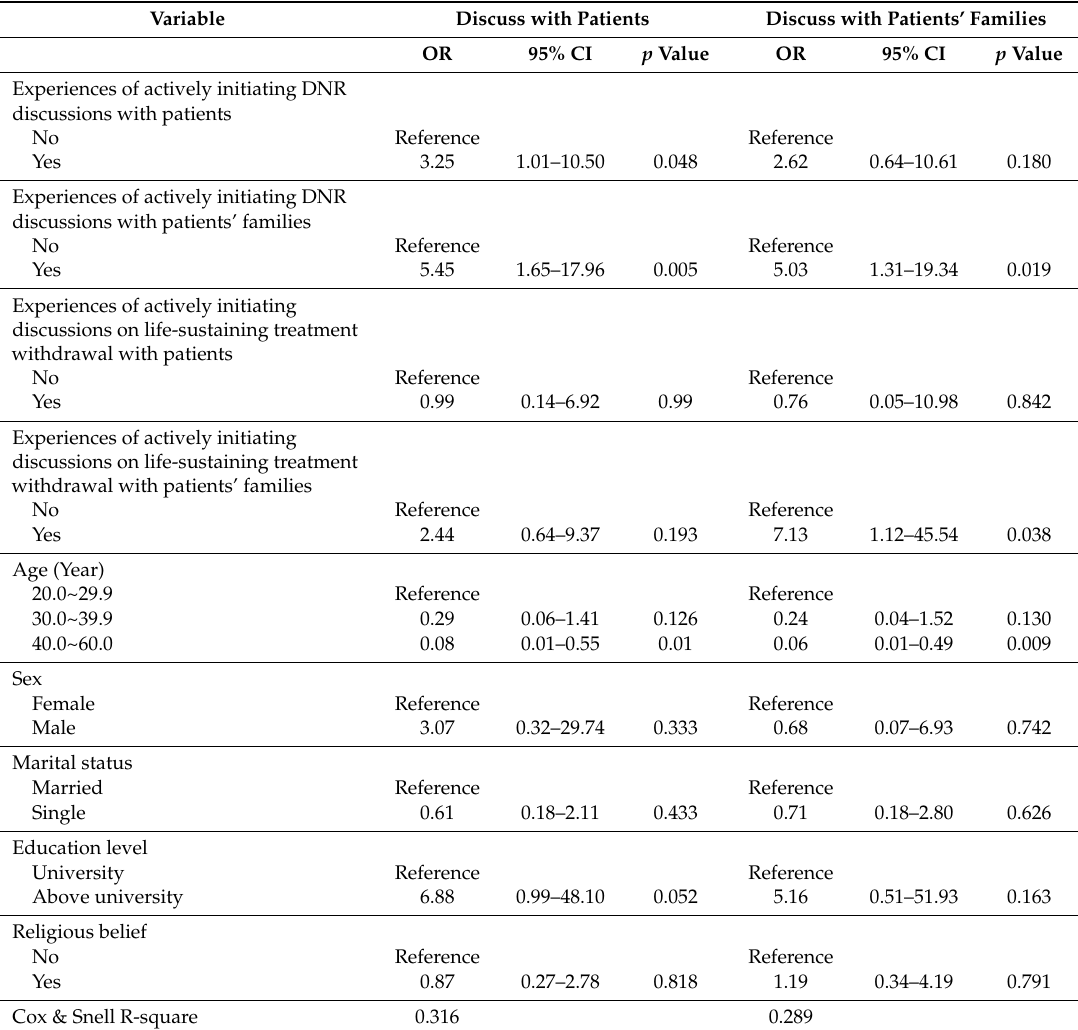
Table 3. Factors related to attitudes toward discussions of do-not-resuscitate (DNR) decisions for terminally ill patients in the future. Variable Discuss with Patients Discuss with Patients’ Families OR 95% CI p